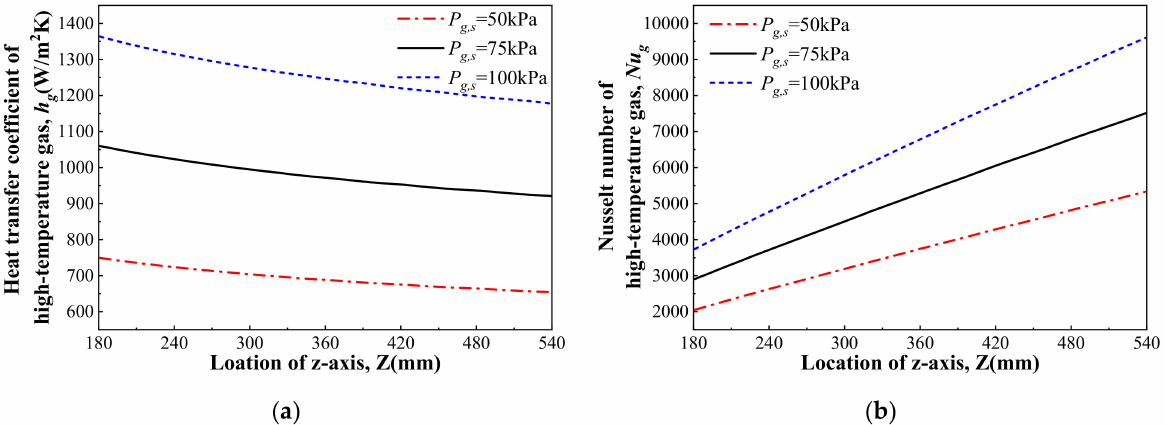
Figure 16. Variation of h g and Nu g with static pressures of gas ( a ) h g ( b ) Nu g . The heat transfer between regenerative cooling panel and high-temperature gas of different total temperature is conducted in Case#4 to Case#7. Compared with Case#1, the total temperature of gas is changed in Case#4 to Case#7, while the mass flow rate and static pressure remains unchanged. The variation of wall temperature T wg and heat flux q g at the centerline of the gas heated surface in these cases is shown in Figure 17. The results showed that T wg and q g almost increases linearly with the increase of T 0 . The rise of T wg is about 72 K and the rise of q g is about 210 kW/m 2 for every 300 K increase of T 0 . The main reason is that the adiabatic wall temperature T aw increases with T 0 , and according to Equations (12) and (13), this will lead to the rise of T wg and q g